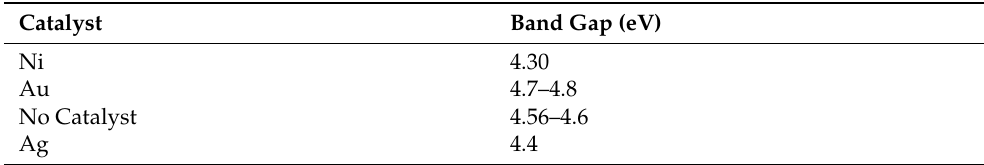
Figure 13. Band gap of gallium oxide nanowires using an Ag catalyst [171]. “Reprinted with permission from Ref. [171]. Copyright (2020), nature”. Table 5. Band gap using different catalysts, [171]. “Reprinted with permission from Ref. [171]. Copyright (2020), nature”.